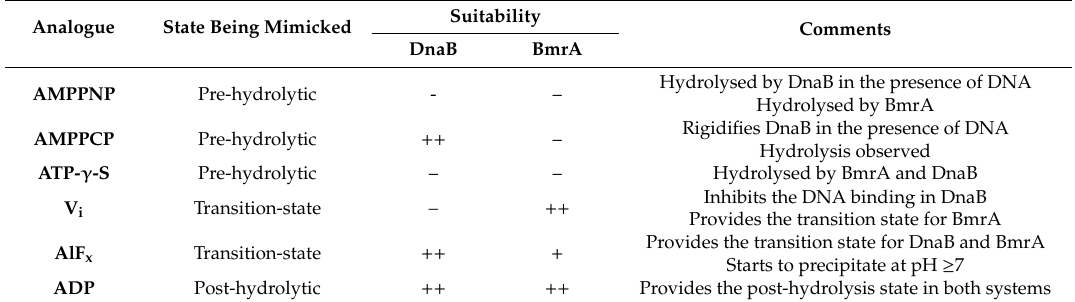
Table 2. Summary of the ATP analogue e ffi ciencies for the two protein systems BmrA and DnaB. ++ indicates high e ffi ciency, + moderate e ffi ciency, - low e ffi ciency and – not e ffi